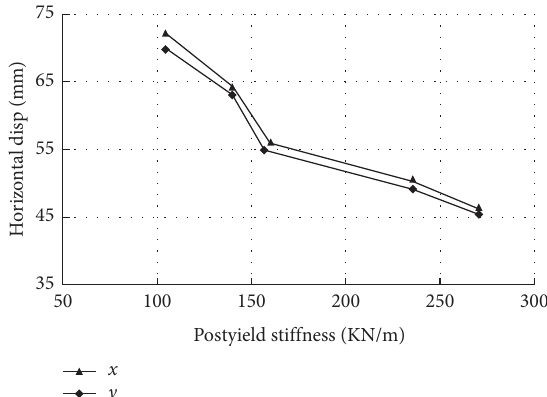
Figure 22: Horizontal displacement related to postyield stiffness.